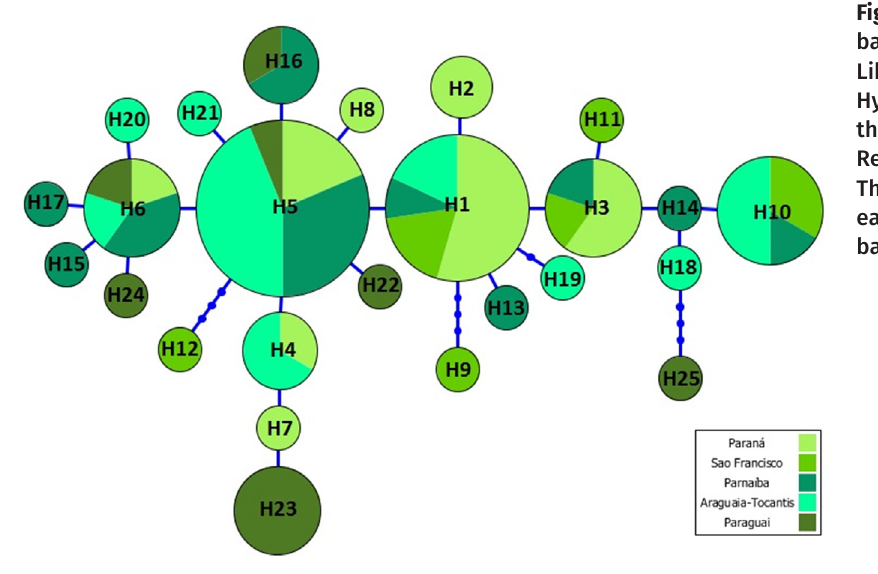
Figure 2. Haplotype network based on the Maximum Likelihood analysis of Hypervariable Domain I of the mitochondrial Control Region of Antilophia galeata . The different colors represent each of the five hydrographic basins shown in Figure 1.